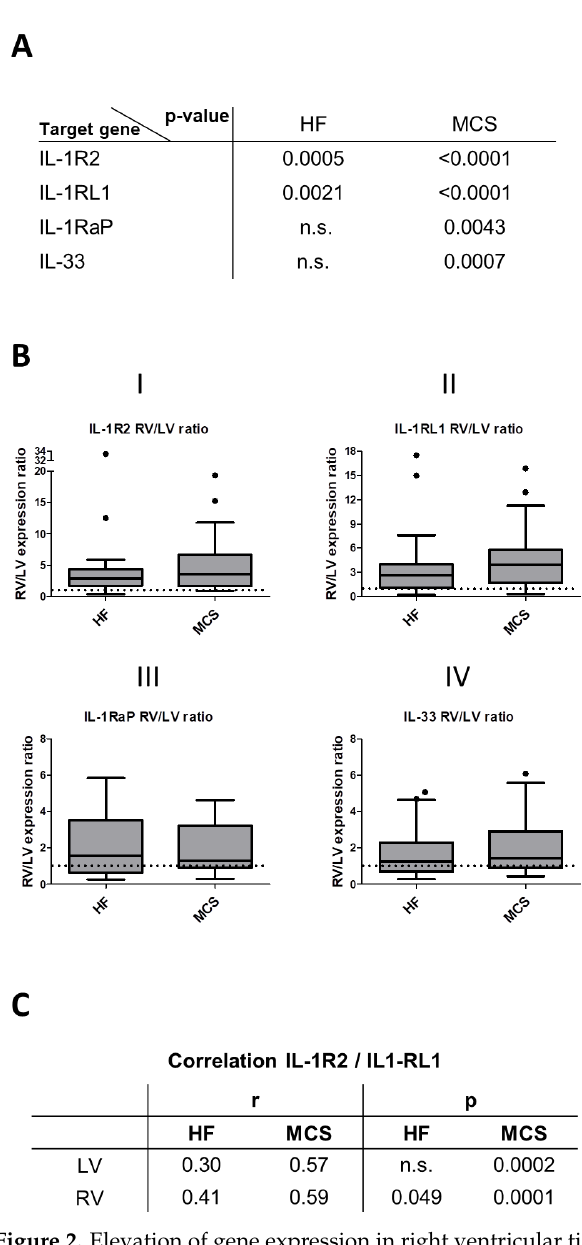
Figure 2. Elevation of gene expression in right ventricular tissue. ( A ) p -values of Wilcoxon matched- pairs signed-rank test comparing left versus right ventricular expression within the same patient is displayed. ( B ) Ratio of right ventricular (RV) to left ventricular (LV) mRNA expression levels of (I) IL-1R2 , (II) IL-1RL1 , (III) IL-1RaP and (IV) IL-33 are calculated. Values higher than one (dotted line) indicate elevated expression in RV. ( C ) Spearman correlation (r) of IL-1R2 with IL-1RL1 is calculated as displayed. Table 3. Local expression levels correlate with CRP and leucocyte serum